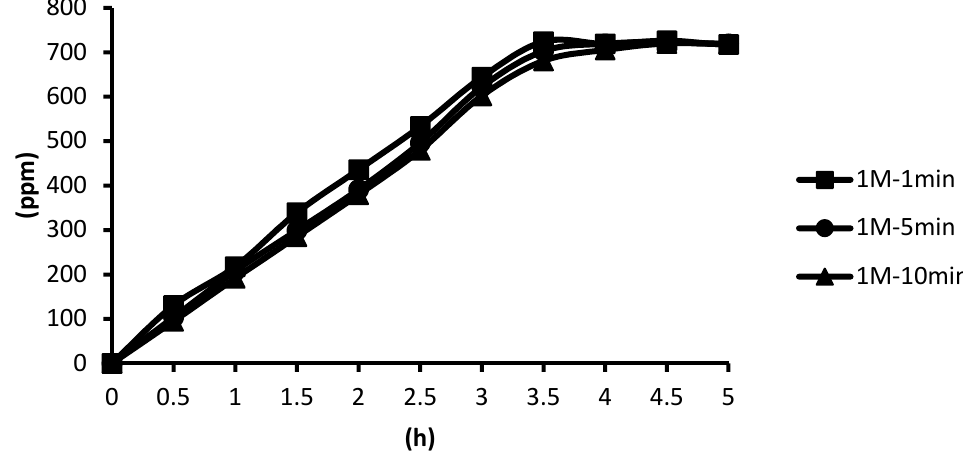
Figure 14. The effect of cross-linking time by 1 M CaCl 2 on releasing of tea tree essential oil from.